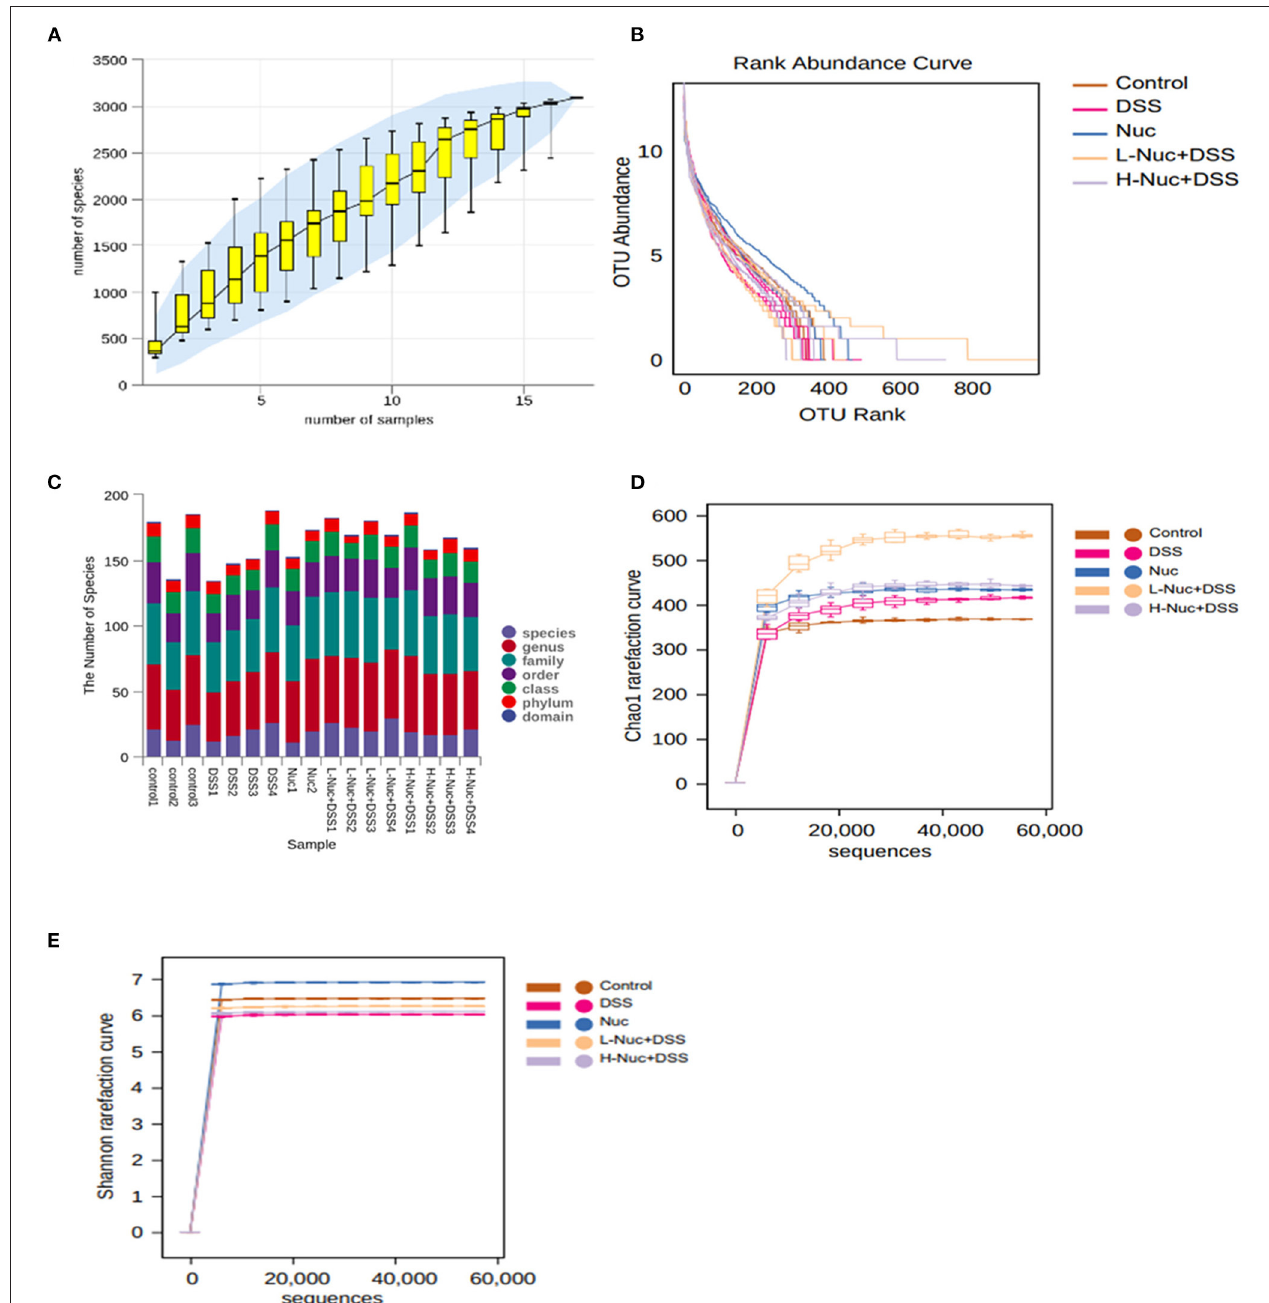
FIGURE 5 | Species annotation and evaluation ( n = 4). (A) pecies accumulation curve of samples. (B) Operational taxonomic units (OTU) relative abundance in individual samples of the control, DSS, Nuc, L-Nuc DSS and H-Nuc DSS groups. (C) Statistical chart of microbial groups at each classification level. The abscissa is arranged according to the sample name, and the abscissa is the number of microbial groups contained in each of the six classification levels of phylum, class, order, family, genus, and species. (D) Chao1 rarefaction curve. (E) Shannon rarefaction